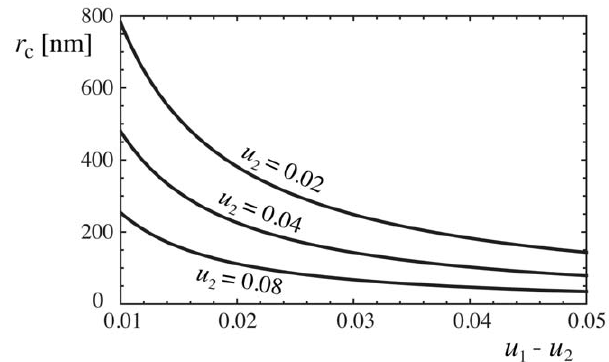
Figure 7. Slopes of the three curves in fig. 6(a) as a function of the ratio l ba = l we of the separation and width of the potential wells. The slopes can be well fitted by a linear function (see text).